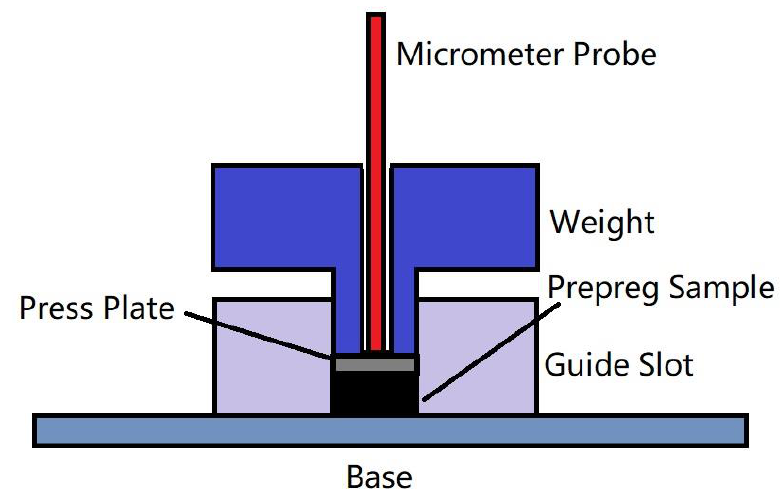
Figure 5. Scheme of prepreg creep curve measuring device.